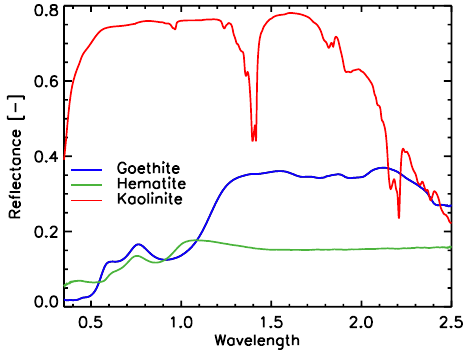
Figure 5. Selected USGS mineral spectra used for spectral angle mapping.